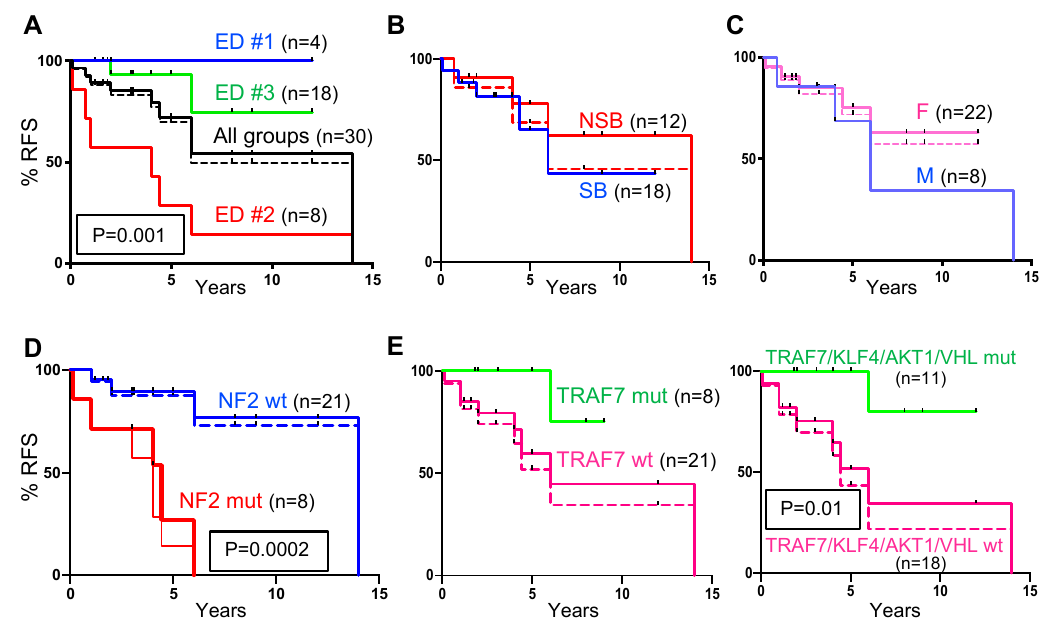
Figure 3. Recurrence-free survival (RFS). RFS color-coded Kaplan–Meier curves are shown with p -values when statistical significance is achieved. The number of patients corresponding to each group is shown in brackets. Color-coded dotted lines correspond to adjusted RFS curves after the removal of the four ED group #1 cases. ( A ) Significantly decreased surgical RFS in ED group #2 compared to group #3. ( B , C ) No significant difference for location and sex (M, males; F, females). ( D ) Significantly decreased RFS in the NF2 -mutated (mut) compared to NF2 -wild-type (wt) groups. The thin and thick red lines correspond to all-treated (surgery and gamma-knife) and surgery-treated NF2 -mut cases, respectively. Statistical-significant differences: NF2 -mut all-treated vs. NF 2-wt ( p = 0.0002, shown) and adjusted ( p = 0.0006); NF2 -mut surgery-treated vs. NF 2-wt ( p = 0.0028) and adjusted ( p = 0.0067). ( E ) Weak protective e ff ect of TRAF7 mutations (left), with statistical di ff erence when combined with KLF4 , AKT1 and VHL mutations